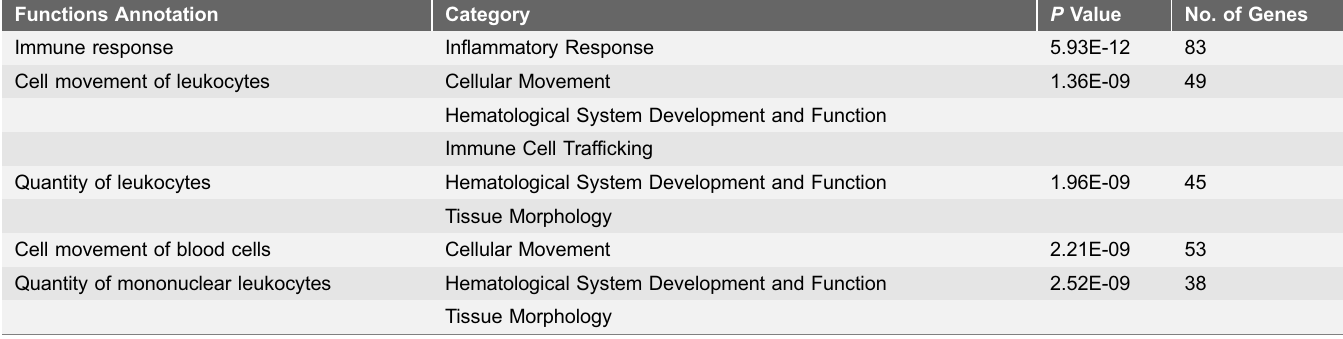
Validation of microarray analysis by qRT-PCR The transcript expression patterns observed by microarray analysis between C. perfringens / E. maxima co-infected Ross chickens and uninfected controls were validated by qRT-PCR for 15 immune-related mRNAs. The levels of all transcripts were consistently increased or decreased by each method of quantification Table 3. The biological functions significantly associated with the differentially expressed transcripts in C. perfringens / E. maxima co-infected Ross chickens compared with uninfected controls. Functions